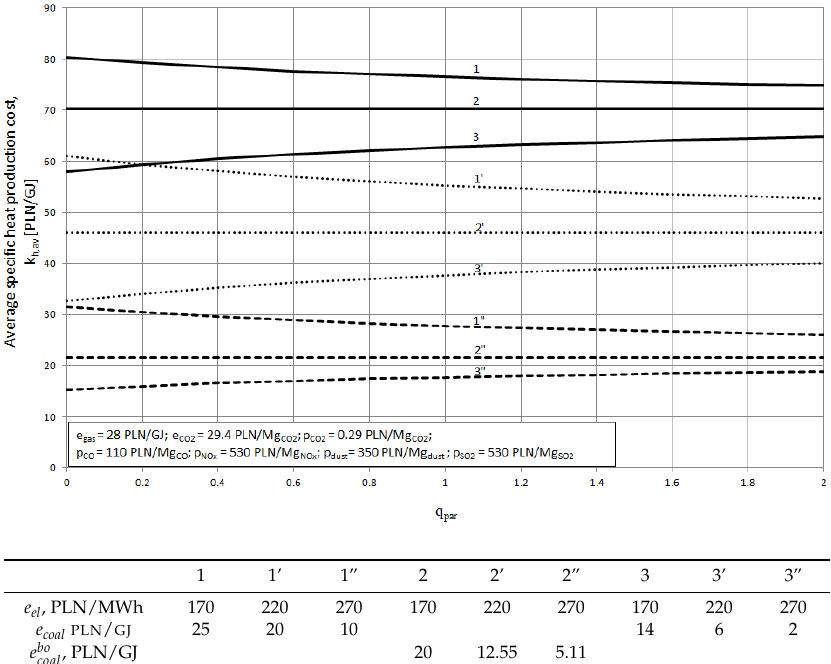
Figure 9. Average specific cost of heat production as a function of q par with the price of coal as a parameter, where: